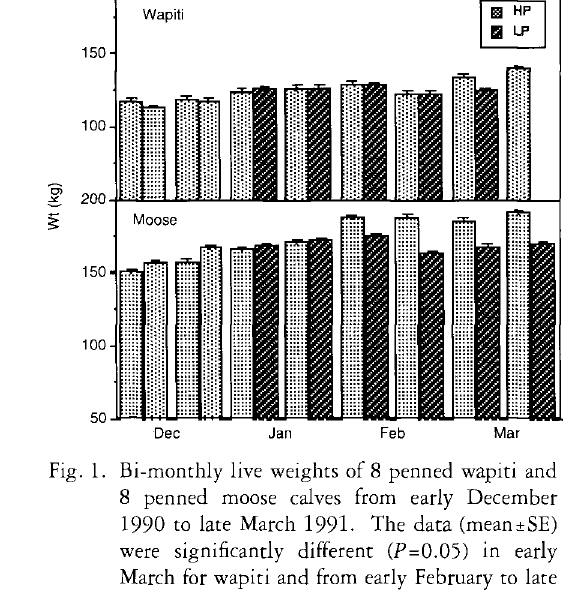
Fig. 1. Bi-monthly live weights of 8 penned wapiti and 8 penned moose calves from early December 1990 to late March 1991. The data (mean + SE) were significantly different (P = 0.05) in early March for wapiti and from early February to late March for moose.